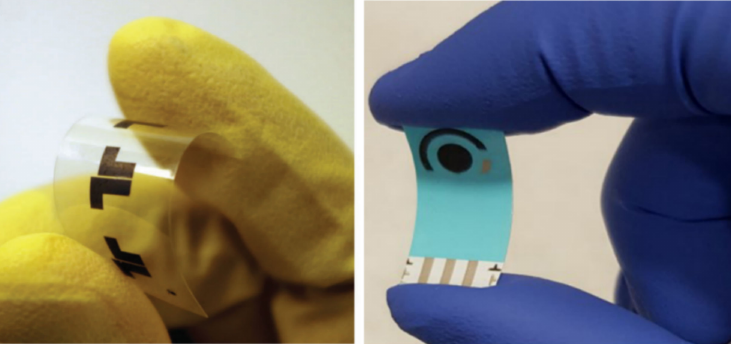
Figure 12. ( Left ) A real life image of micro-supercapacitors on a flexible polyethylene terephthalate (PET) substrate. Reproduced from [137] with permission from The Royal Society of Chemistry. ( Right ) A real life image of a pH sensor using melanin on a polyethylene (PE) substrate. Reproduced with permission from Tehrani et al. [121] under Creative Commons Attribution—Published by IOP